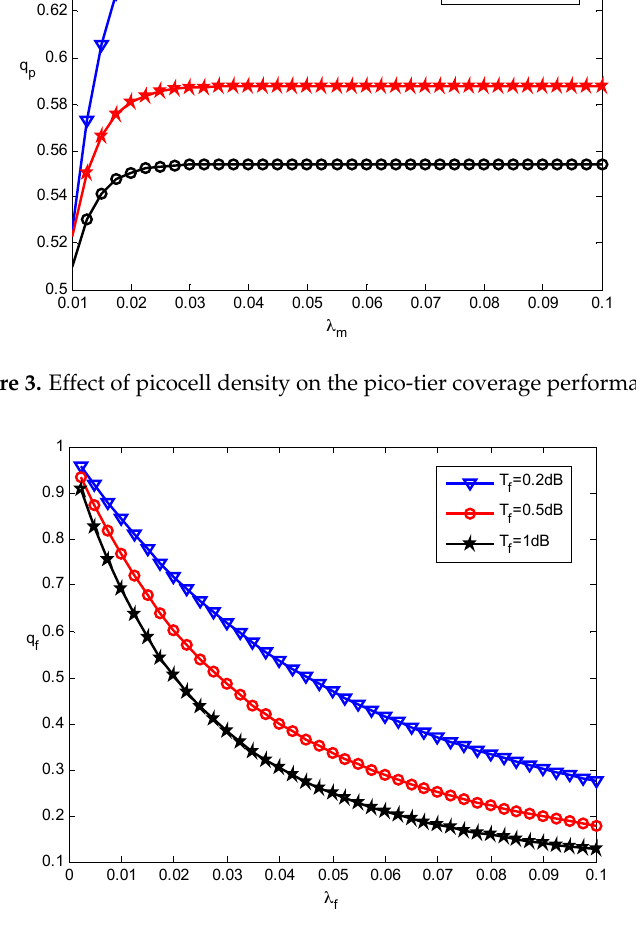
Figure 5. Energy efficiency vs. SBS density ratio when T p = 3.5 dB.